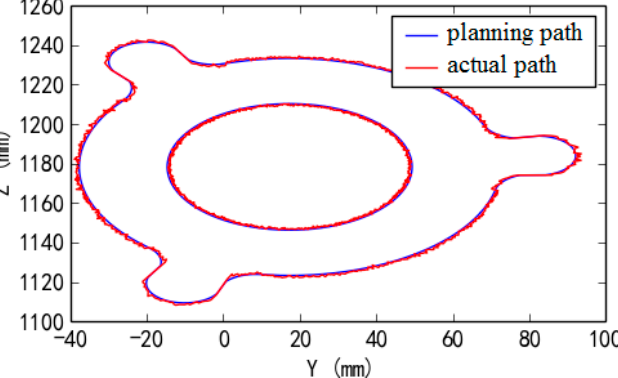
Figure 29. Experimental deburring results of target planning path and actual tool path of top facet.